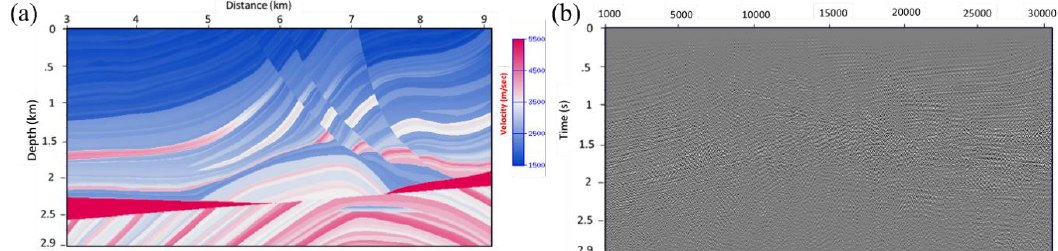
Figure 8. ( a ) Marmousi velocity model with a velocity range from 1650 to 4600 m/sec. Three major faults containing unconformity and overburden cause complexity in the velocity model for anticline structures. ( b ) Synthetic shot gather data are generated using finite difference modeling.